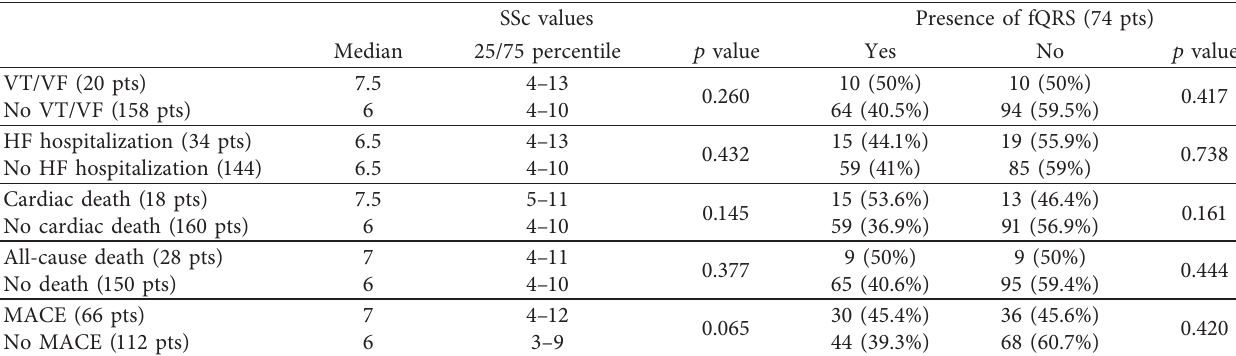
Table 5: Distribution of SSc values, and prevalence of fQRS, according to the occurrence of secondary